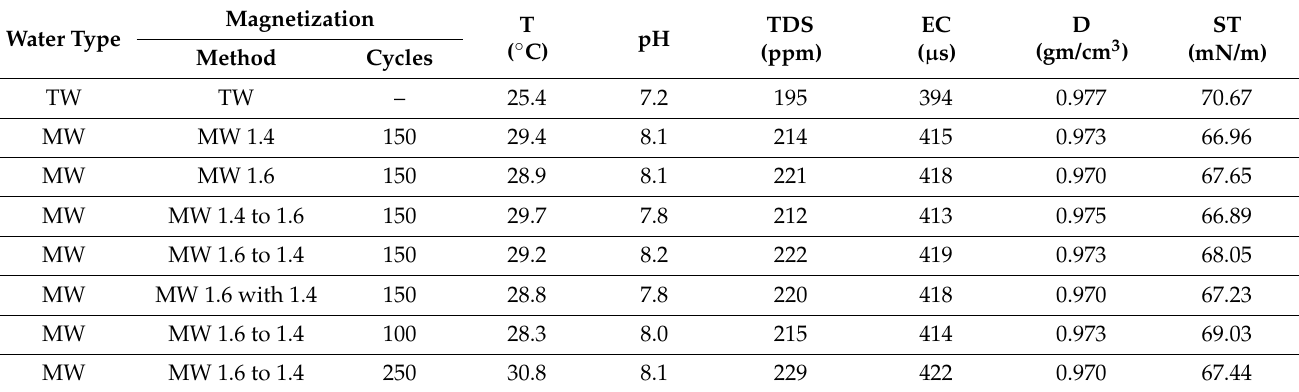
Table 4. Measured physical and chemical properties of